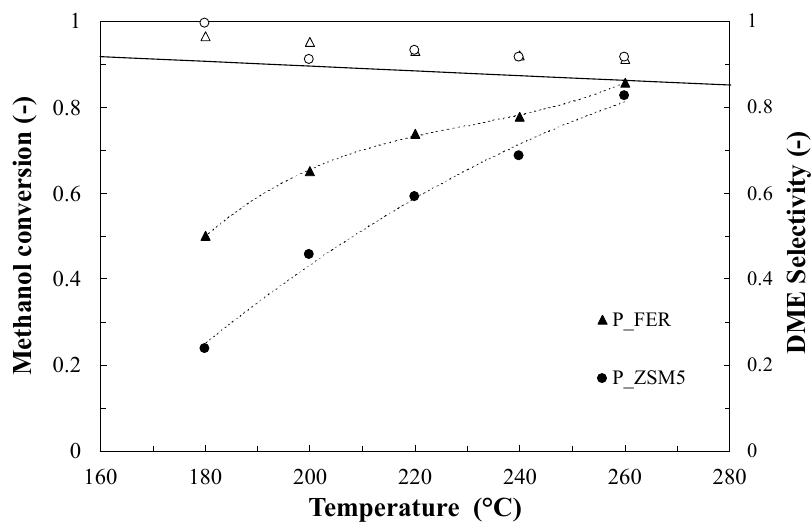
Figure 2. Methanol conversion (closed symbols) and DME selectivity (open symbols) for the parent samples. Test conditions: Methanol = 5.6%; Carrier flow rate (N2) = 60 NmL / min; Weight Hourly Space Velocity (WHSV) = 4.5 h − 1 .